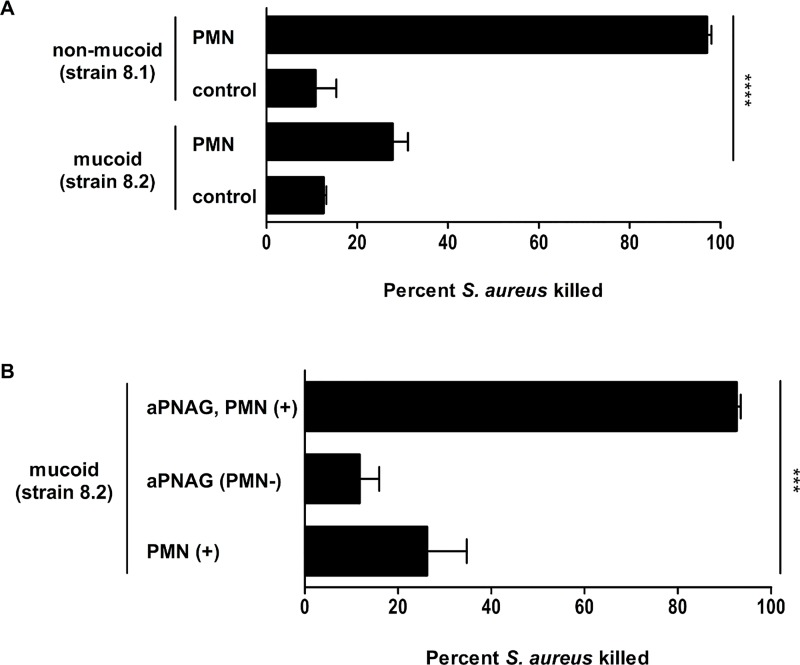
Opsonophagocytic killing of non-mucoid (strain 8.1) and mucoid S. aureus (strain 8.2) isolates by human neutrophils (PMNs) from healthy volunteers.The assay contained 2.5 x 106 neutrophils, 5 x 105 CFU S. aureus, 1% guinea pig serum (as a complement source), in a total volume of 500 μl MEM-BSA. Some assays included antibodies against PIA/PNAG raised in rabbits (1% PIA/PNAG). Control samples contained PMNs and S. aureus or antiserum and S. aureus alone with no PMNs. After 2 h of incubation, samples were vortexed and diluted in sterile deionized H2O to lyse the PMNs to release internalized bacteria. The lysate was plated on TSA plates to enumerate bacterial counts. Percent killing was calculated by the reduction in CFU/ml after 2 h compared with that at time zero. A) Significantly more non-mucoid compared to mucoid bacteria were killed in the presence of neutrophils (97% versus 28%, p<0.0001). In control wells, where neutrophils were absent, only 10% of bacteria died. B) By adding antibodies against PIA/PNAG to wells with mucoid isolates and neutrophils, 93% of bacteria were killed compared to only 26% killing of mucoid isolates in the presence of neutrophils but lacking the specific antibodies (p = 0.0002). All experiments were repeated three times. Results are shown as means and standard deviation. *** p-value ≤ 0.001; **** p-value ≤ 0.0001.